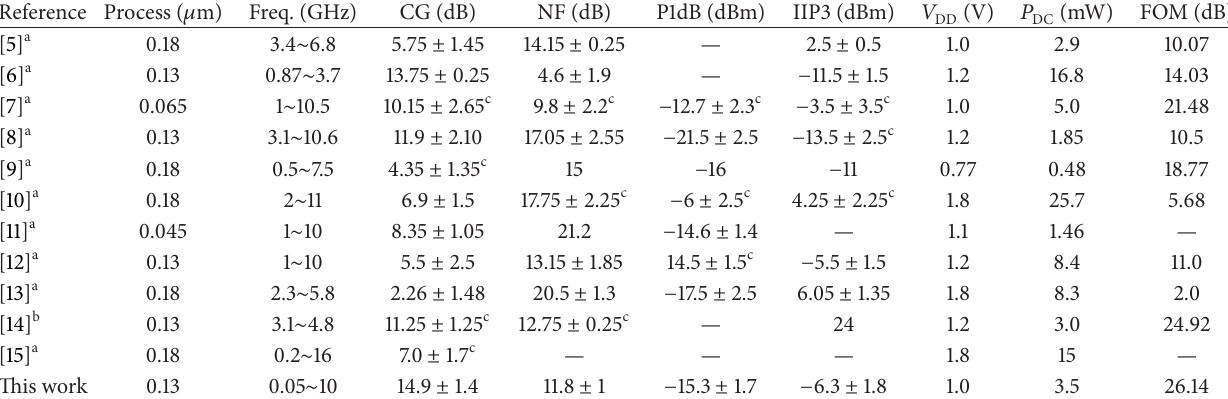
Table 1: Summary of wideband mixer performance and comparison with prior published work.